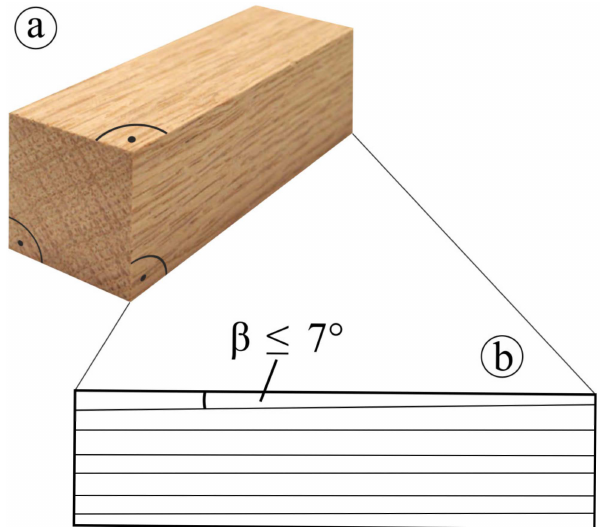
Figure 6. ( a ) The ideal wood structure for bending; ( b ) The allowable grain misalignment. The symbols with dots symbolise the right angles. Adapted from [59], with permission from B á der,